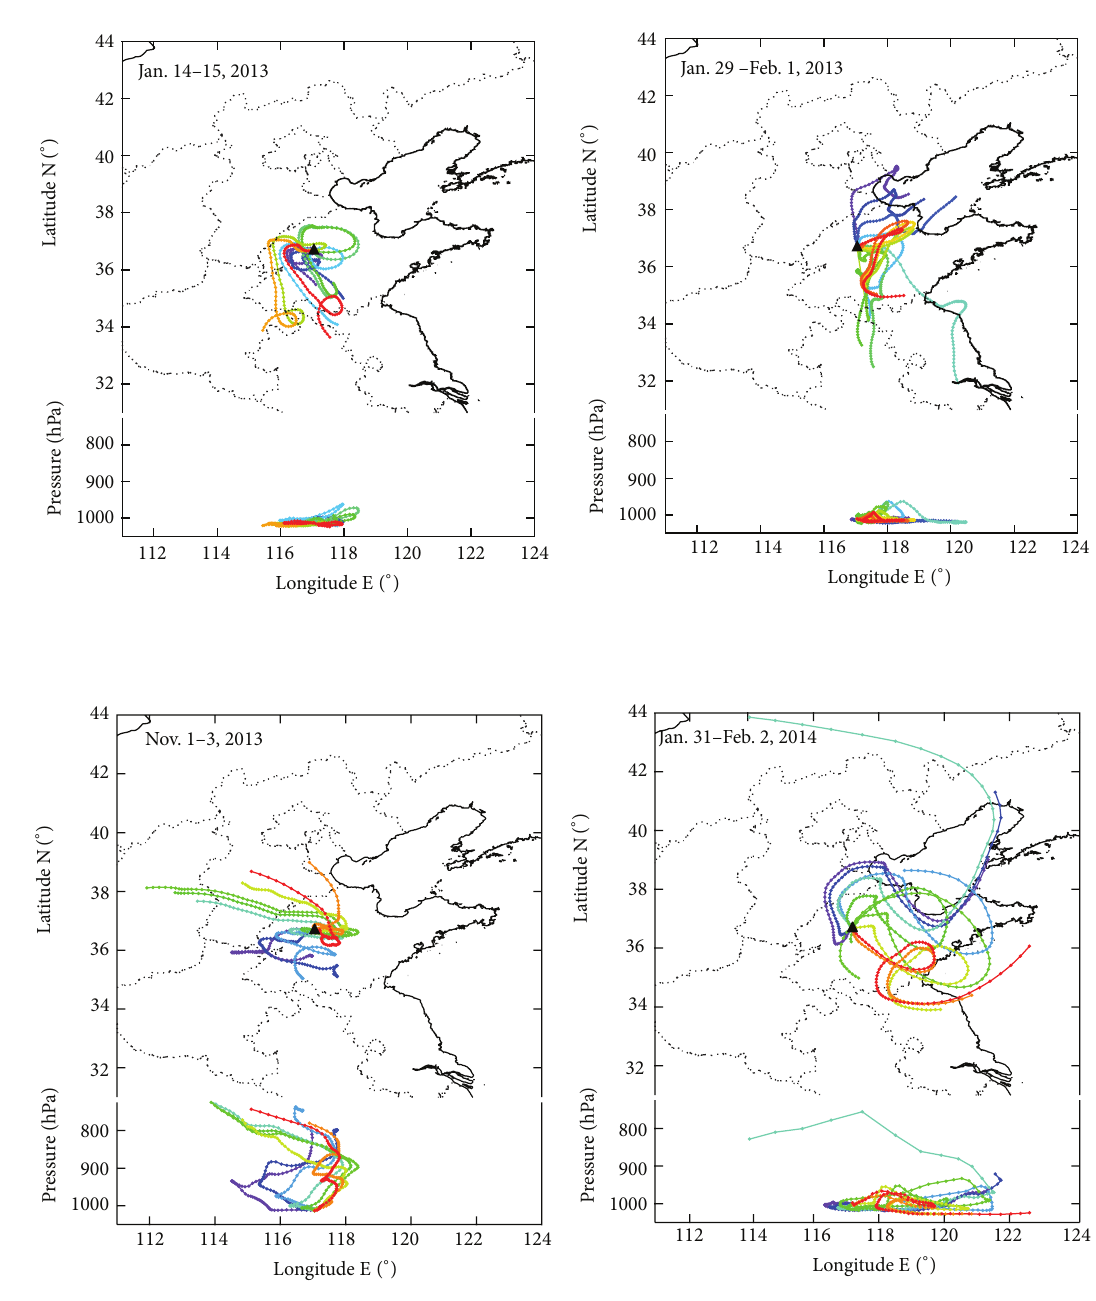
Figure 2: Air-mass back trajectories and the changes in height indicated by pressure for the four fog events occurring in Ji’nan during the period from March 2012 to February